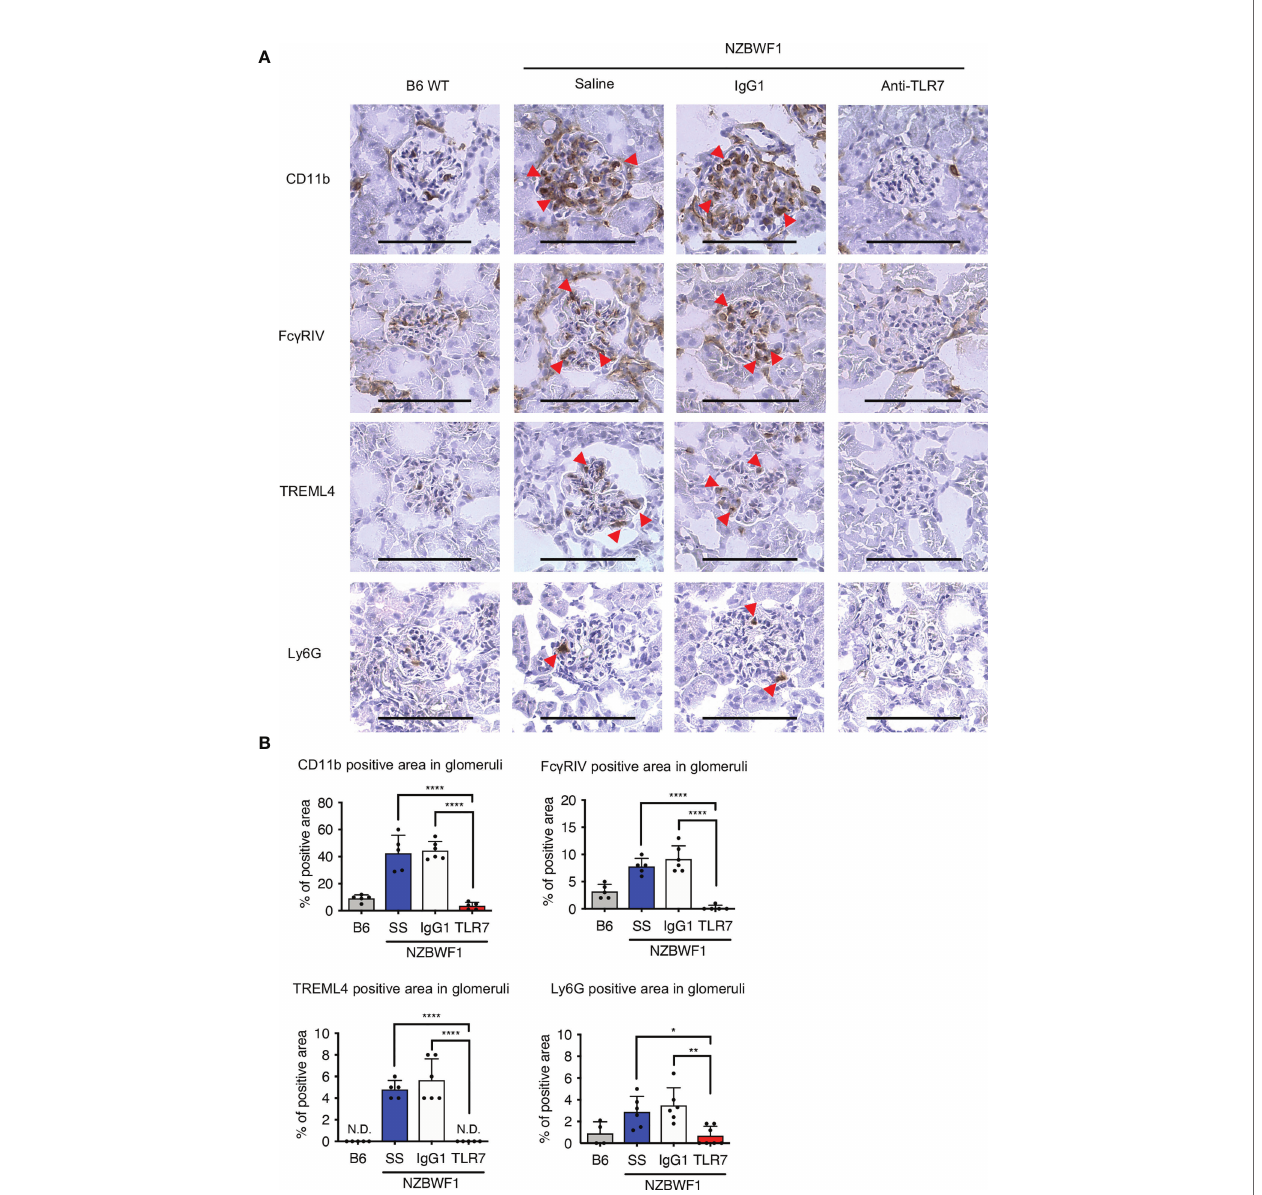
FIGURE 6 | Anti-TLR7 mAb inhibited patrolling monocyte in fi ltration into glomeruli. (A, B) NZBWF1 mice were administered saline, IgG1 or anti-TLR7 mAb from age 12-16, to 35-40 weeks and compared with age-matched B6 mice. (A) Representative images show immunohistological fi ndings of glomerular myeloid cells expressing CD11b, Fc g RIV, TREML4 or Ly6G. Red arrowheads, positively stained cells. Scale bar, 100 m m. (B) Ratios of stained areas in each glomerulus statistically analyzed using fl uorescence microscopy. Numbers of glomeruli assessed (5-10 from one kidney in B6 ( n ≥ 4), saline ( n = 5), control IgG1 ( n = 6), and anti-TLR7 mAb ( n ≥ 5) (A, B) . Data were statistically analyzed using one-way ANOVA with Tukey ’ s multiple comparison tests. * p < 0.05, ** p < 0.01, **** p < 0.0001. N.D., not detected. Data are shown as individual points and as means ± SD for each experimental